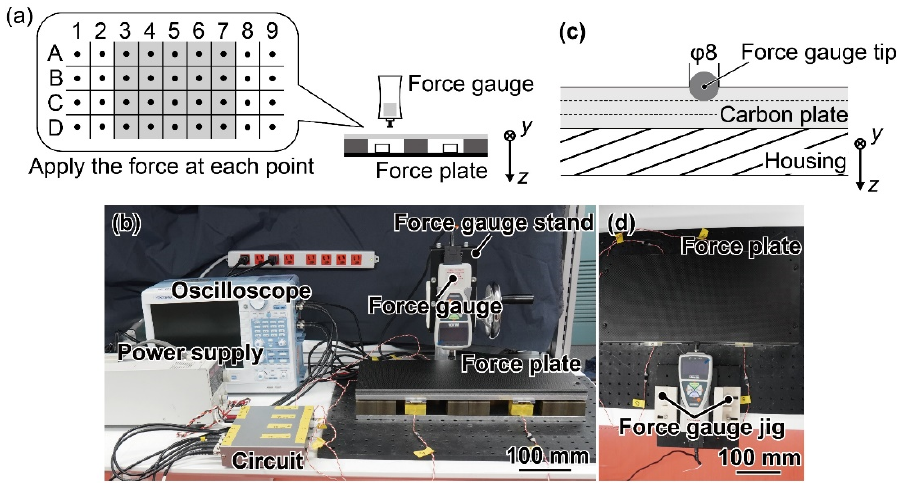
Figure 8. ( a ) Schematic image and ( b ) photograph of the calibration in the z -direction. ( c ) Schematic image and ( d ) photograph of the calibration in y -direction.